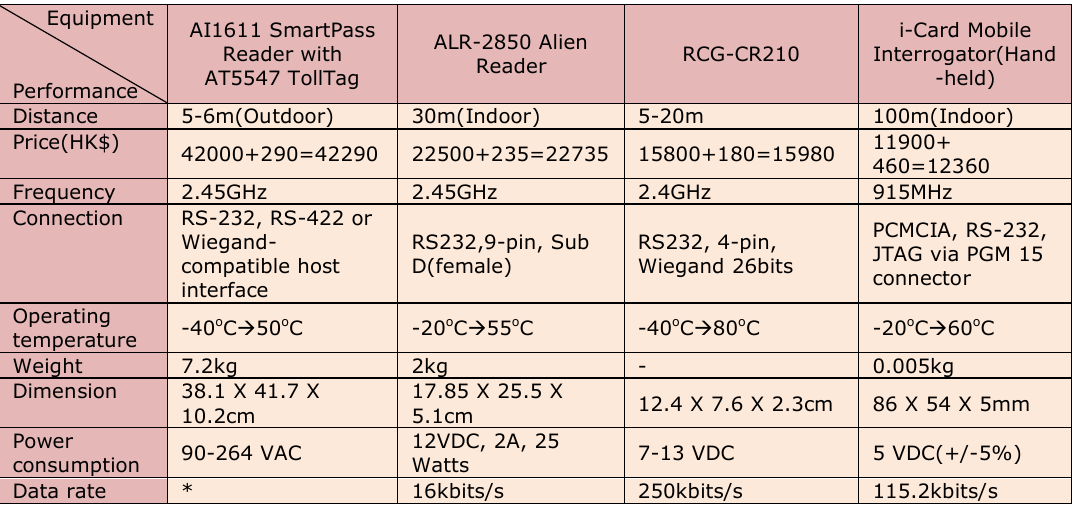
Table 2. Comparison of different RFID